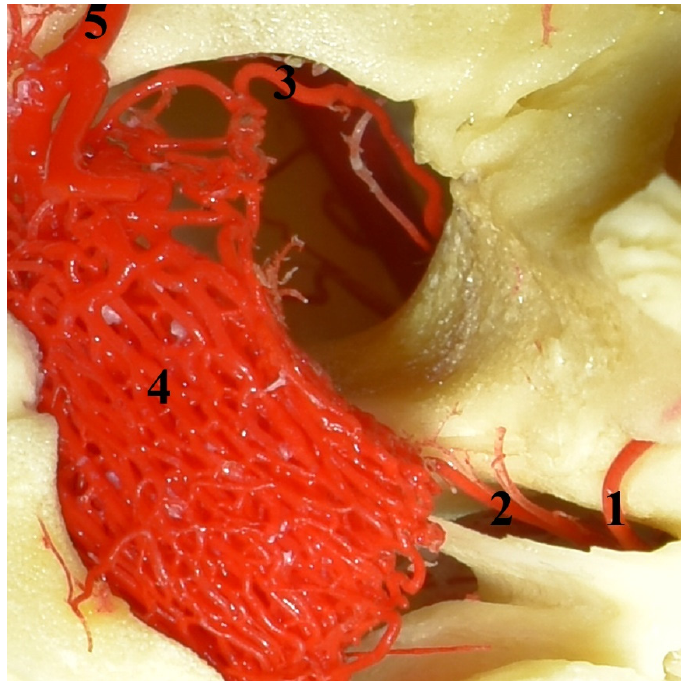
Figure 2. The rostral epidural rete mirabile in the Eurasian wild boar ( Sus scrofa ). A dorsal view